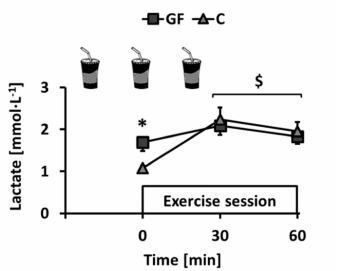
Figure 2. Changes over time of earlobe blood lactate concentration in GF and C groups during training sessions. GF received glucose-fructose drinks and C received water − 20, 0, and +20 min relative to exercise onset. Effects of exercise (E) and intervention (I) were compared using a mixed-model analysis. Paired and unpaired contrasts were used to determine differences between rest and exercise (E effect: time = 0 min vs. time = 30–60 min: $: p < 0.01) and GF vs. C (I effect: *: p < 0.05). Mean ± SEM for n = 8 participants in all